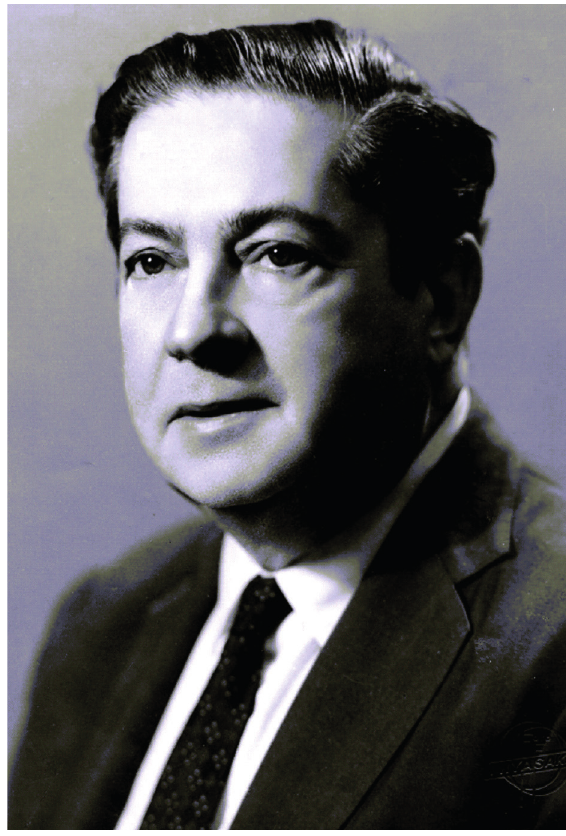
Figure 1 - Professor Maurício Rocha e